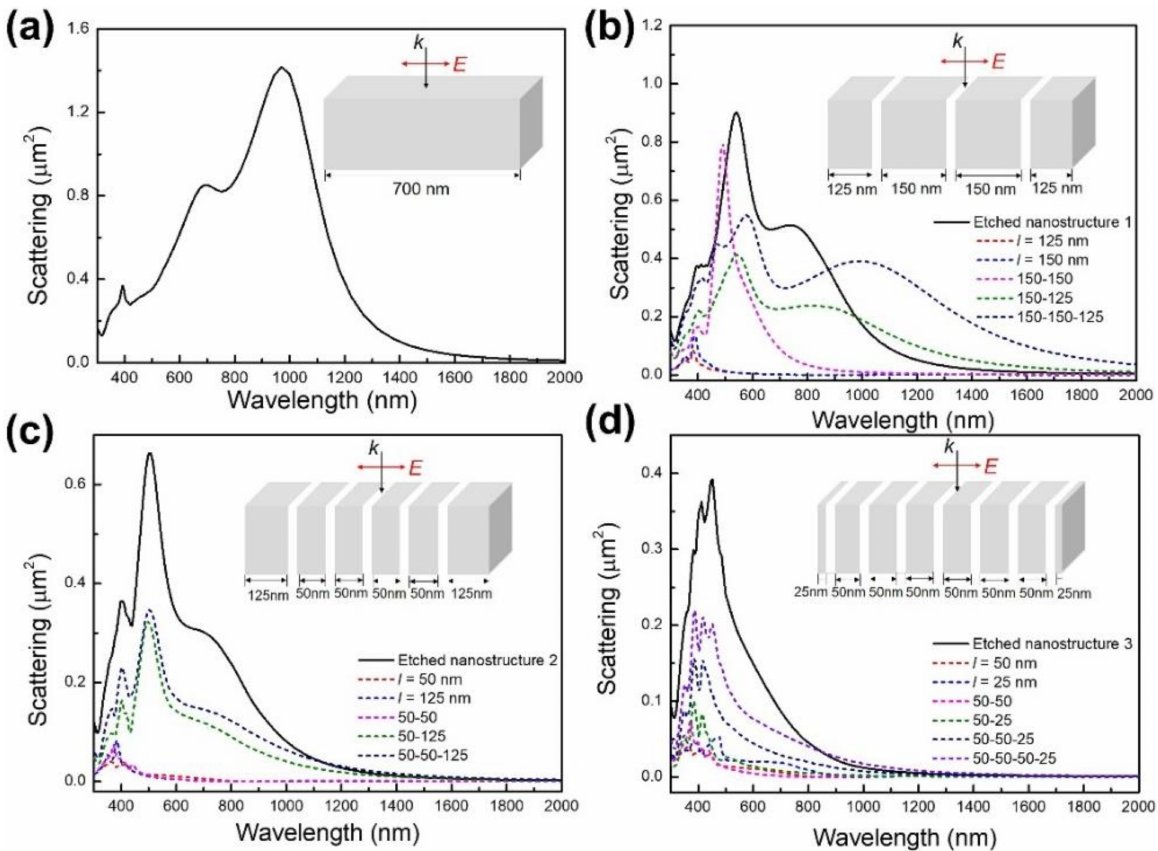
Figure 4. The LSPR property of a large-size Ag nanobar ( w = t = 200 nm, l = 700 nm) before and after being etched along the length direction. ( a ) The simulated scattering cross-section of an original large-size Ag nanobar and ( b – d ) three etched nanostructures (black solid lines), individual nanobars (red and blue dashed lines) and the coupling effect of small-size nanobars (other colored dashed lines) simulated at an incident angle ( θ = 0 ◦ ) in air (RI = 1.0). The insets show the corresponding schematic diagrams of a large-size Ag nanobar before and after the etch process. The width and thickness of each etch in white is 200 nm and the length is 50